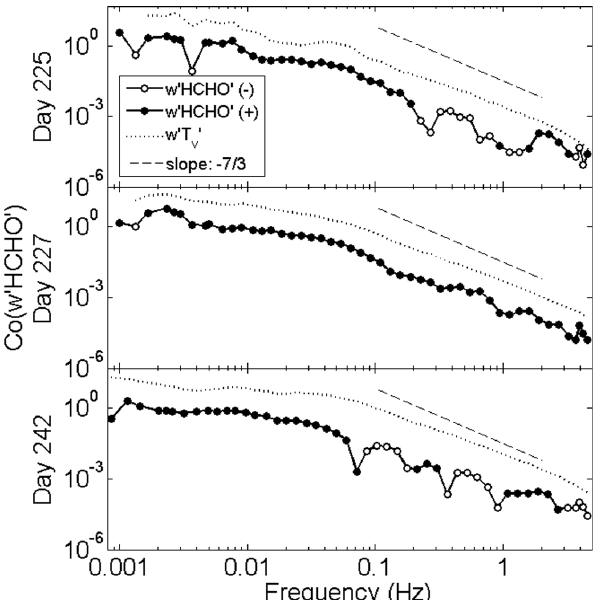
Fig. 2. Average cospectra of HCHO and virtual temperature with vertical wind speed during half-hour periods from 10:00 to 14:00 on 13 August (Day 225), 15 August (Day 227), and 30 August (Day 242). Cospectra were binned into 50 bins spaced equally in loga- rithmic frequency space, and each bin was averaged. The positive w 0 HCHO 0 points (closed circles) designate a positive covariance, whereas negative w 0 HCHO 0 points (open circles) designate nega- tive